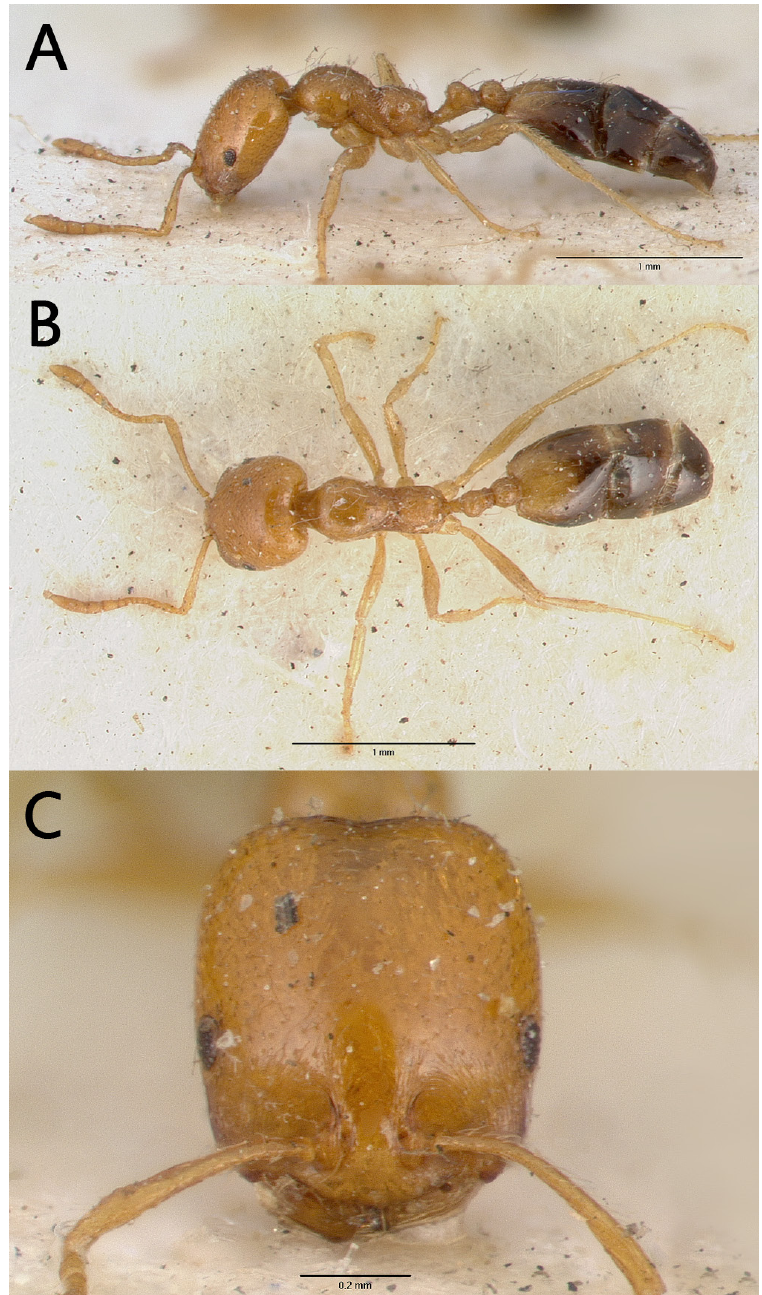
Fig. 8. Trichomyrmex destructor (Jerdon, 1851), lectotype, worker (CASENT0008623). A . Body in profile. B . Body in dorsal view. C . Head in full-face view (photos: April